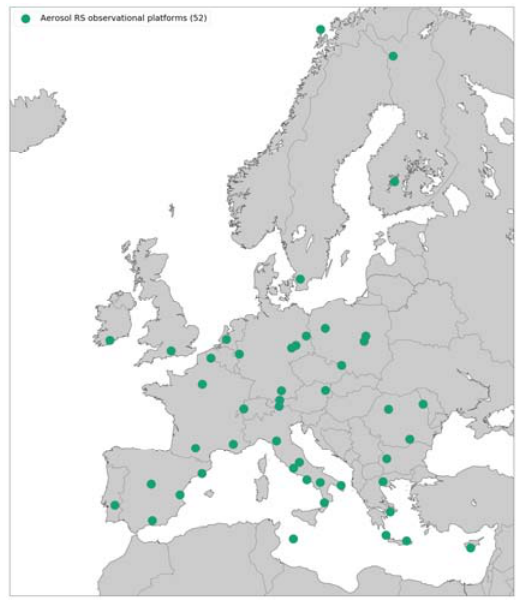
Figure 2: Distribution of ACTRIS aerosol remote- sensing sites over Europe as foreseen by 2025. Several additional sites are located outside of Europe (Arctic, Tropics, Central